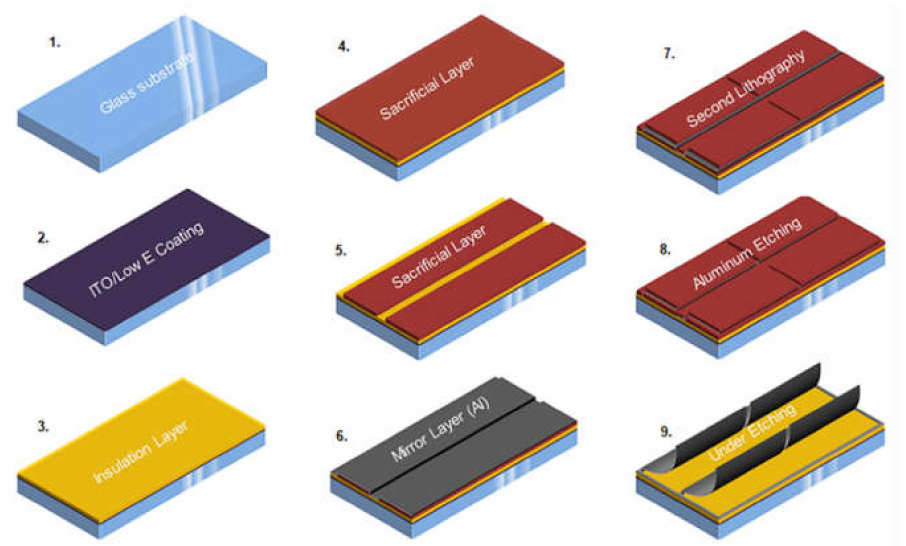
Figure 2. Steps involved in the fabrication process of the MEMS-based micromirrors